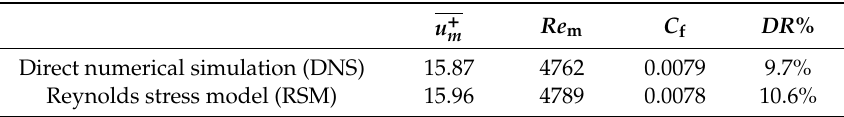
Table 1. Comparison of bulk mean